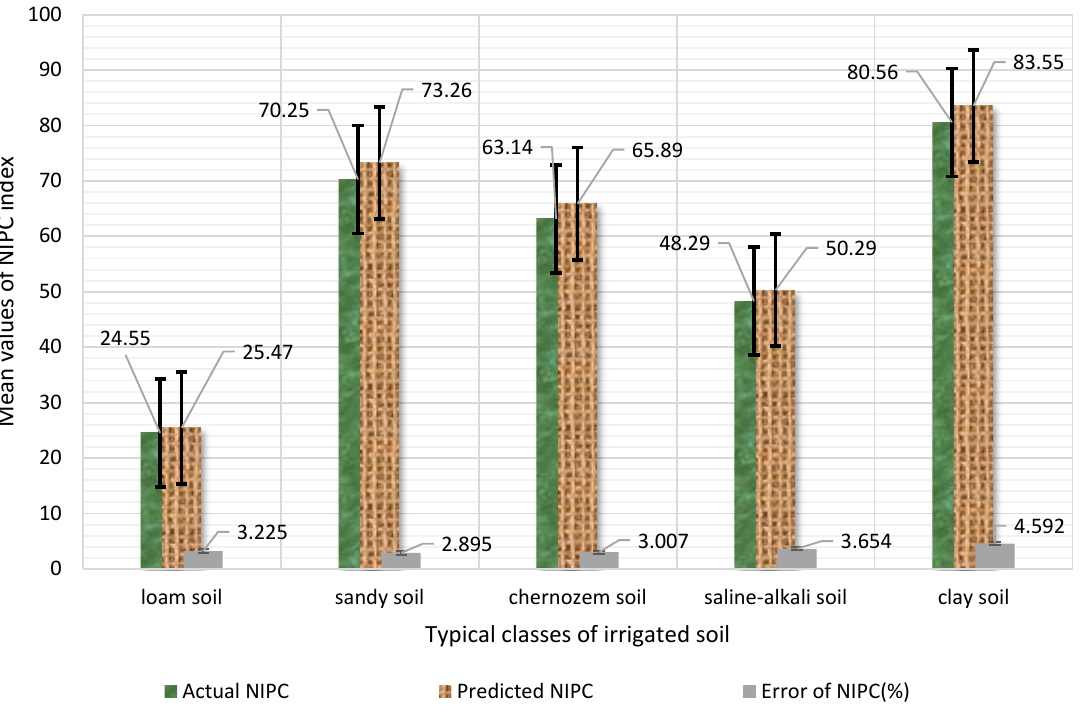
Figure 21. Comparison between the actual and predicted NIPC values in typical soil types.